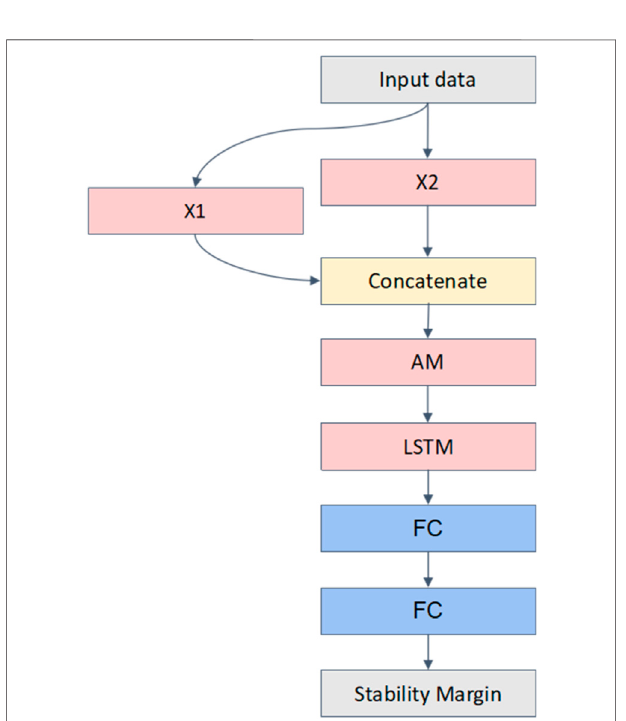
FIGURE 8 | Model one structure based on the LSTM network and AM.